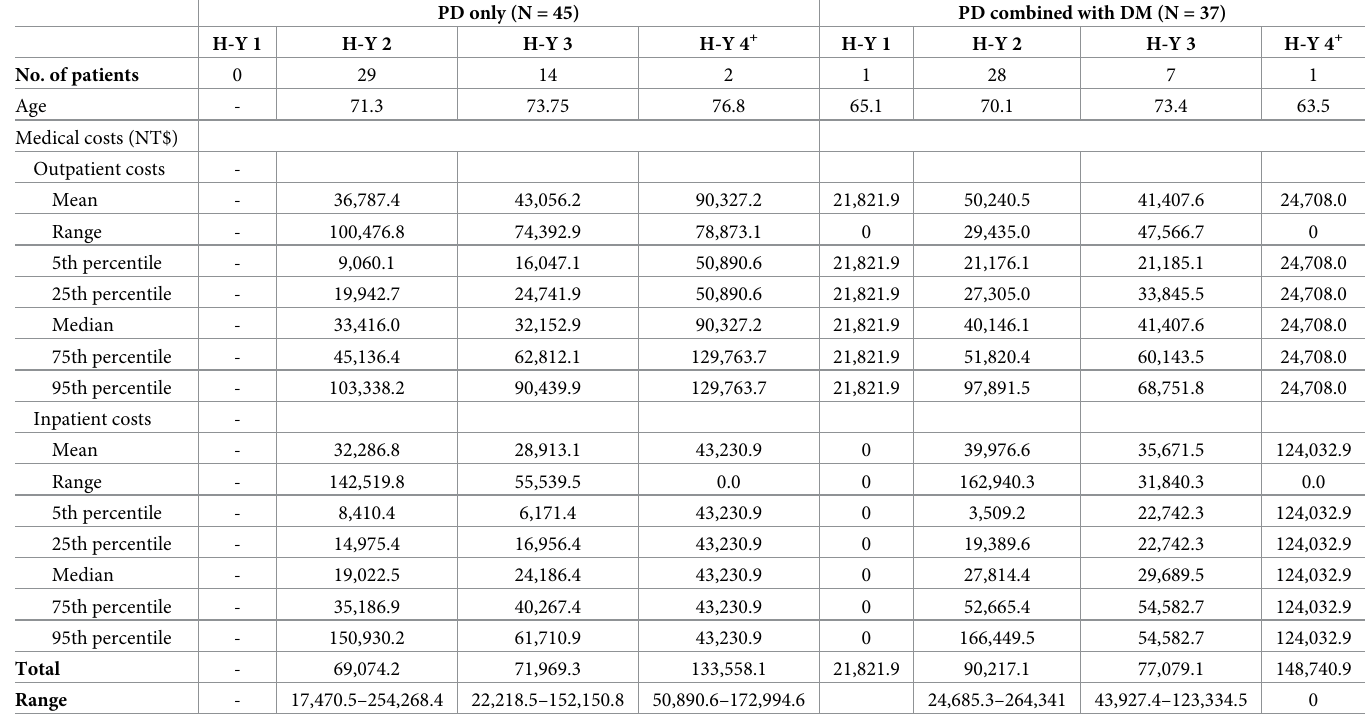
Table 3. Medical cost of PD only and PD combined with DM per patient during one